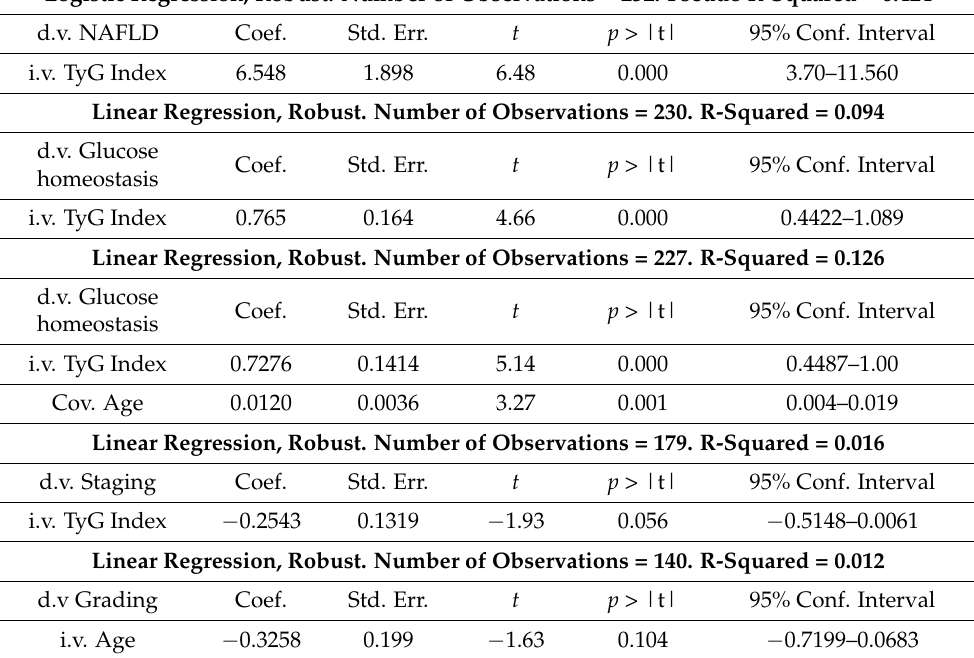
Table 4. Prediction of NAFLD presence, IFG/T2DM by the triglycerides/glucose index in the whole population and of stages and grades of BCa patients. Logistic Regression, Robust. Number of Observations = 232. Pseudo R-Squared =